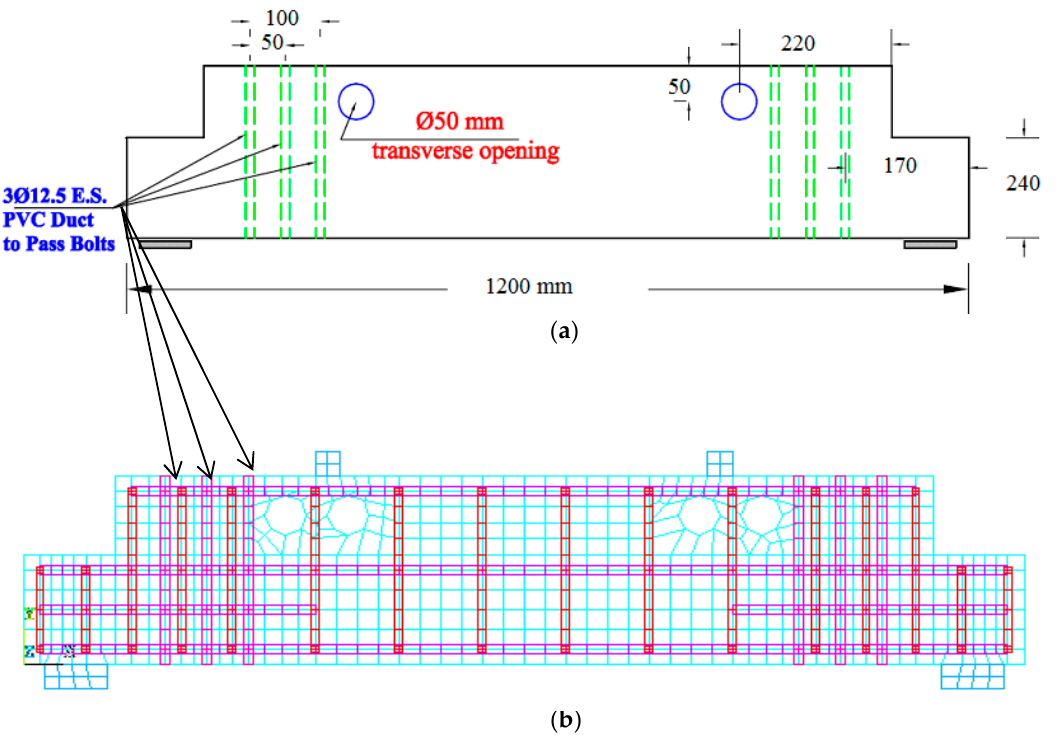
Figure 8. Experimental details and numerical simulations of model DET7. ( a ) Geometry layout in the previous experimental investigation [39]. ( b ) Numerical modelling.